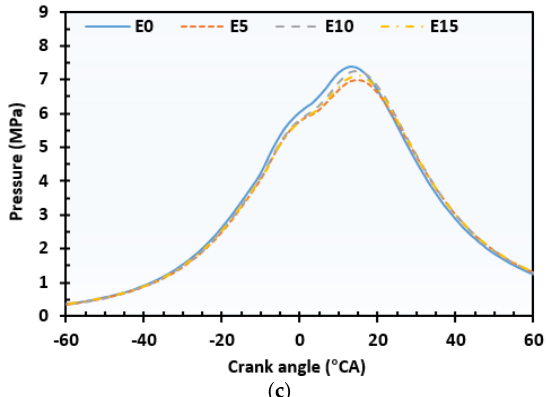
Figure 3. In-cylinder pressure: ( a ) 40 Nm; ( b ) 60 Nm; ( c ) 80 Nm.